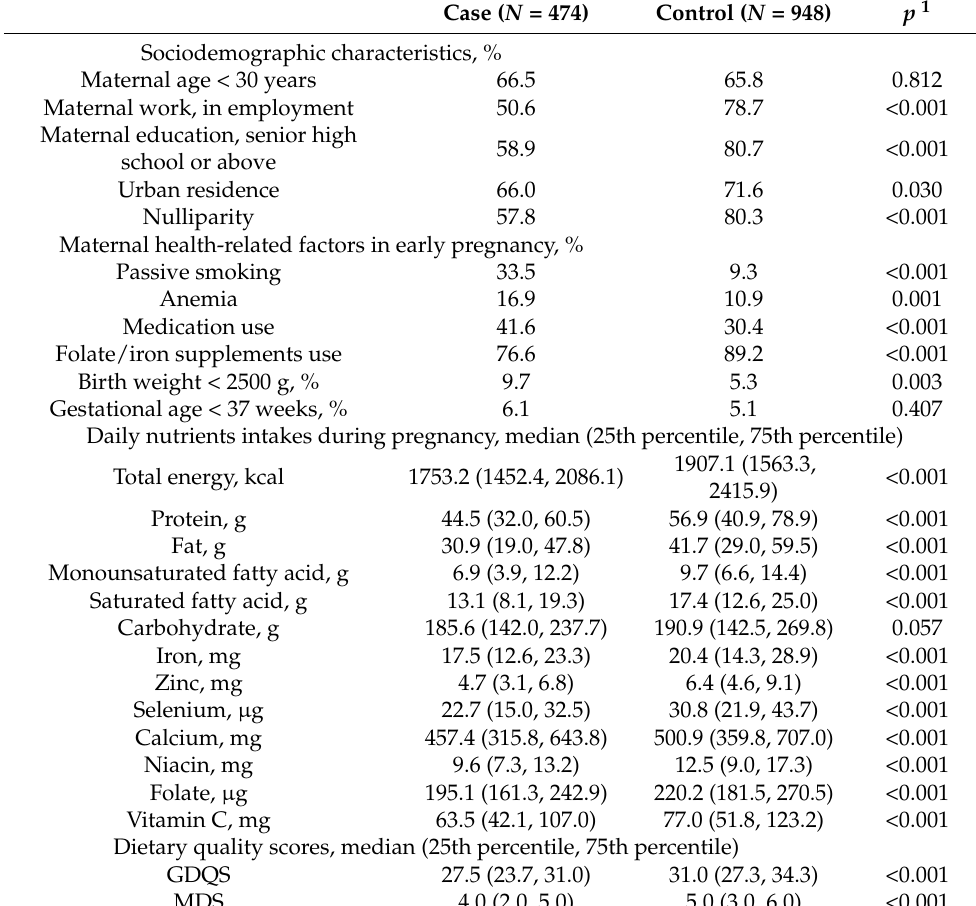
Table 1. Baseline characteristics of the study